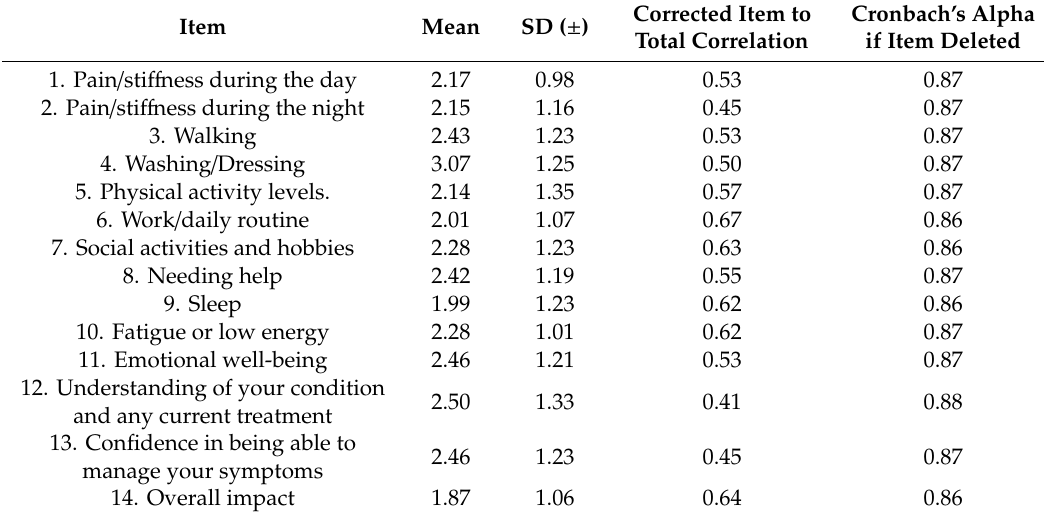
Table 4. Statistics of the MSK-HQ-Ar